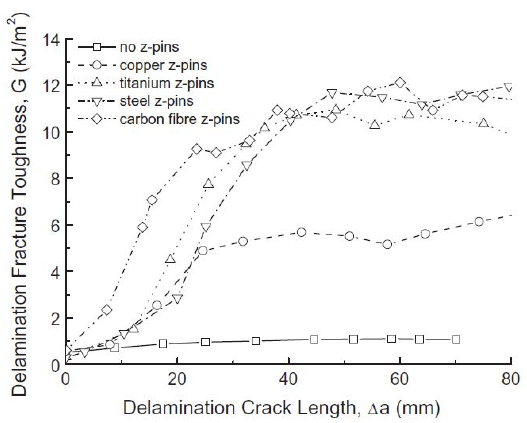
Figure 56. E ff ect of z-Pin material in mode I apparent fracture toughness of a z-Pinned laminate (d = 0.51 mm, 2.0 vol%, t = 4 mm, [0 6 [90 / 0] 4 ] s pre-preg) [37].